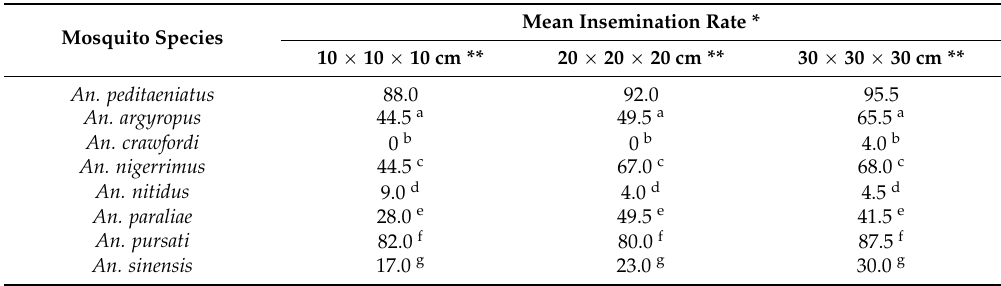
Table 1. Insemination rates of the eight species of the Hyrcanus Group using various cage sizes (10, 20 and 30 cubic cm cages) at DRS of